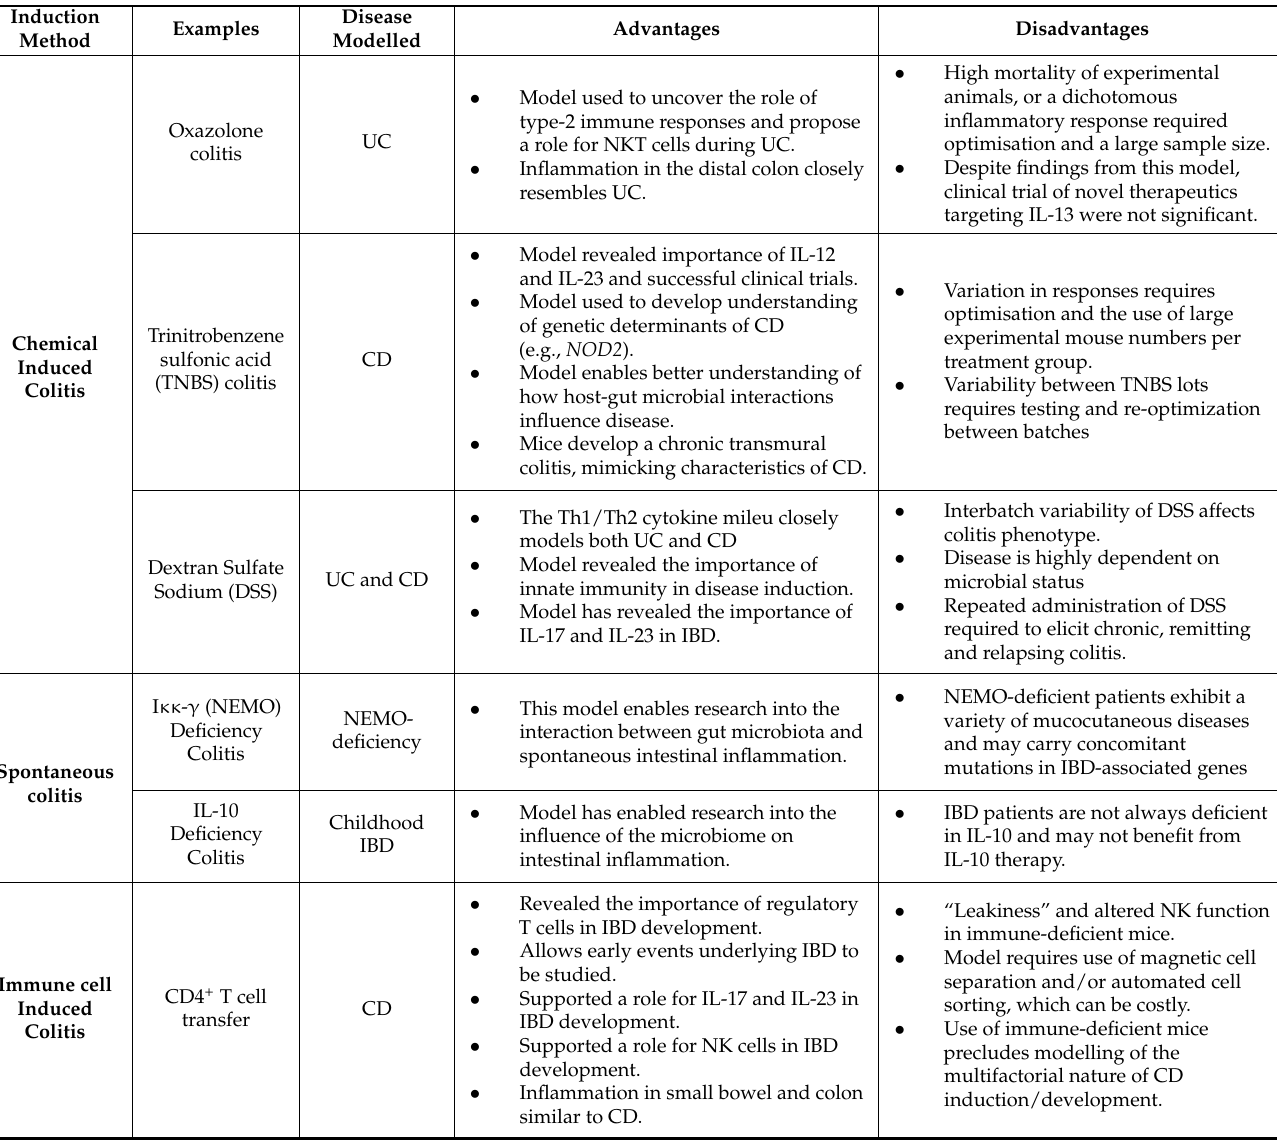
Table 1. Summary of the advantages and disadvantages of the most widely used pre-clinical murine models of IBD, organised by induction